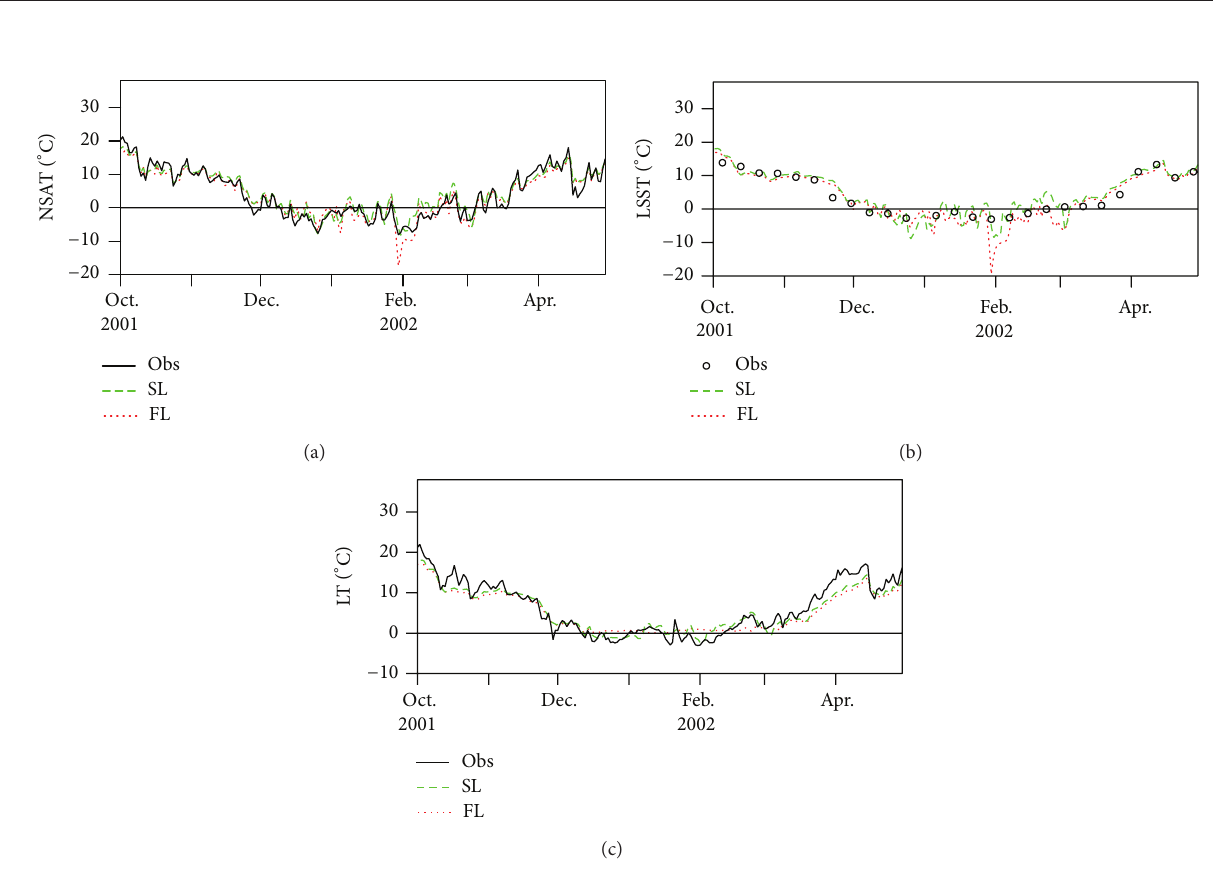
Figure 2: Observed and simulated temperature in FL and SL experiments.